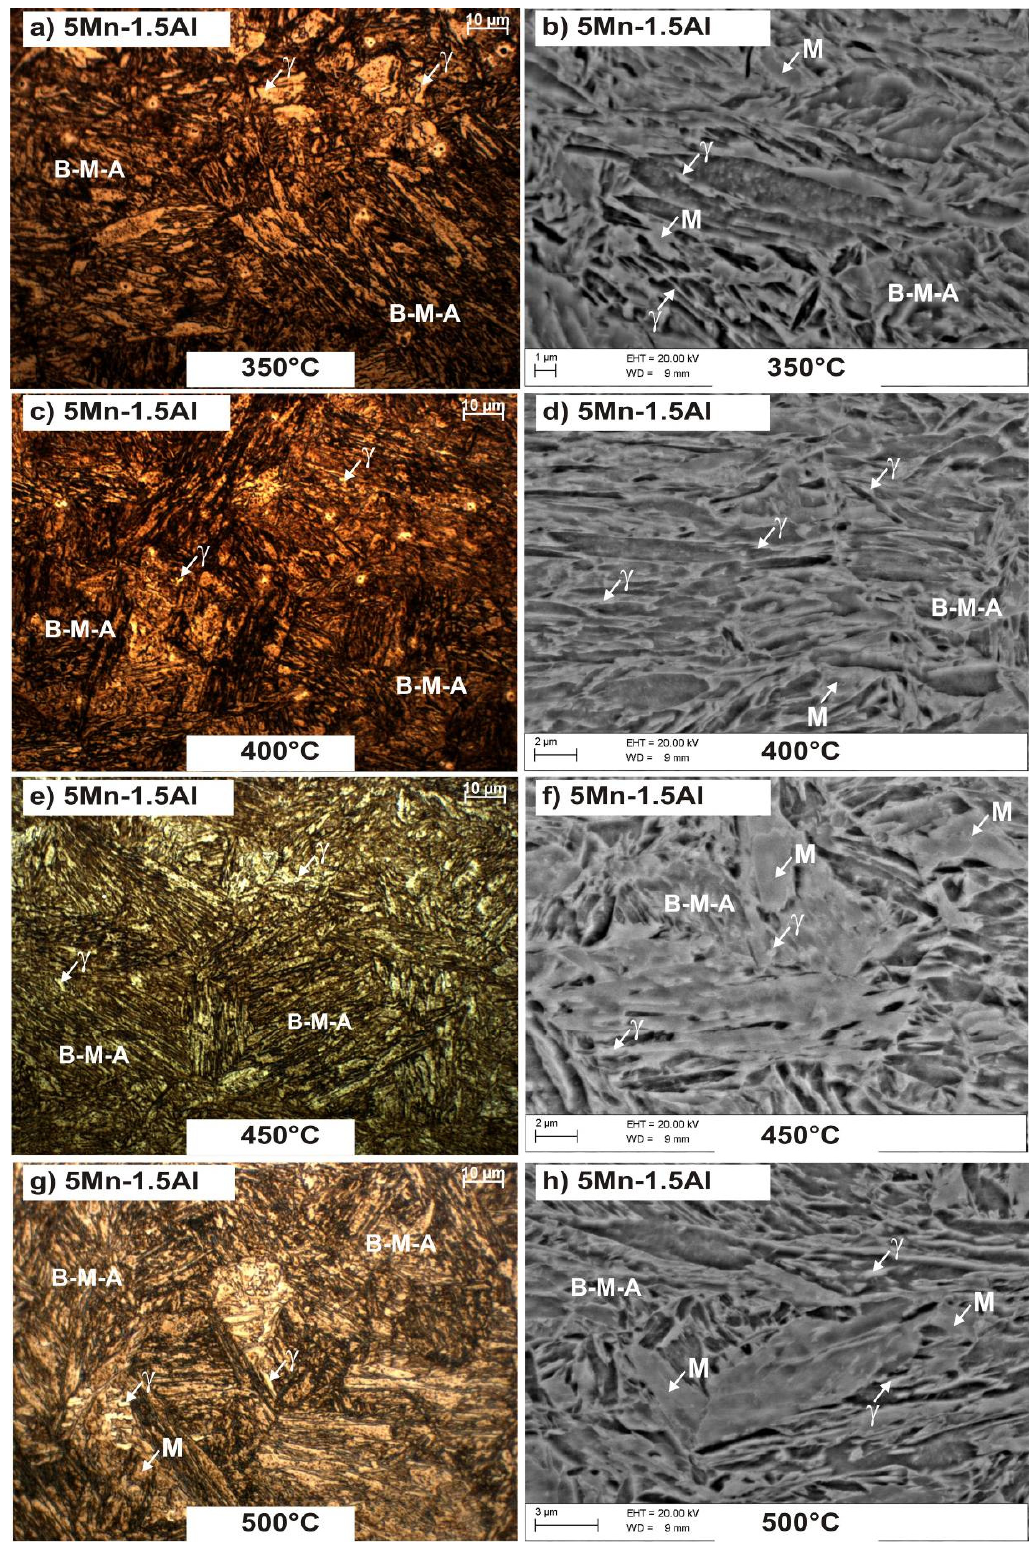
Figure 9. Bainitic–martensitic microstructure of 5Mn steel isothermally held at: ( a ) and ( b ) 350 °C, ( c ) and ( d ) 400 °C, ( e ) and ( f ) 450 °C, ( g ) and ( h ) 500 °C. ( c , d ) 400 ◦ C, ( e , f ) 450 ◦ C, ( g , h ) 500 ◦